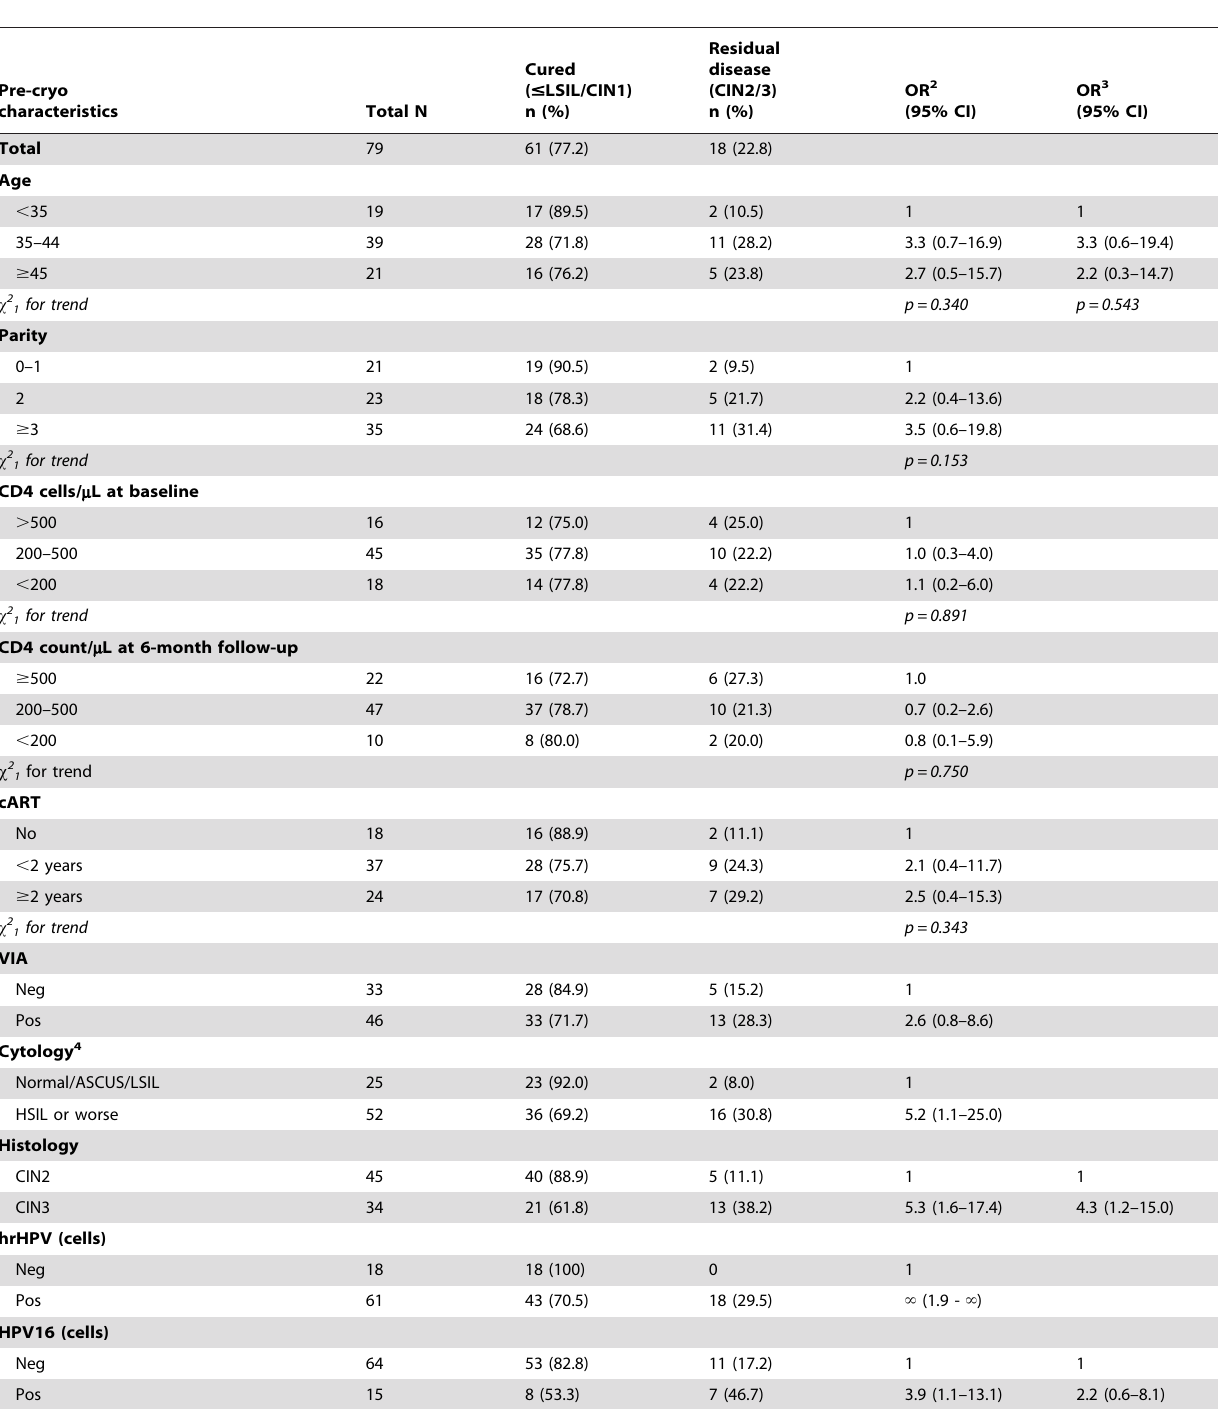
Table 1. Odds ratio (OR) and 95% confidence intervals (CI) for residual disease six months after cryotherapy (cryo) for CIN2/3 by selected pre-treatment characteristics. 1 Kenya, 79 HIV-positive